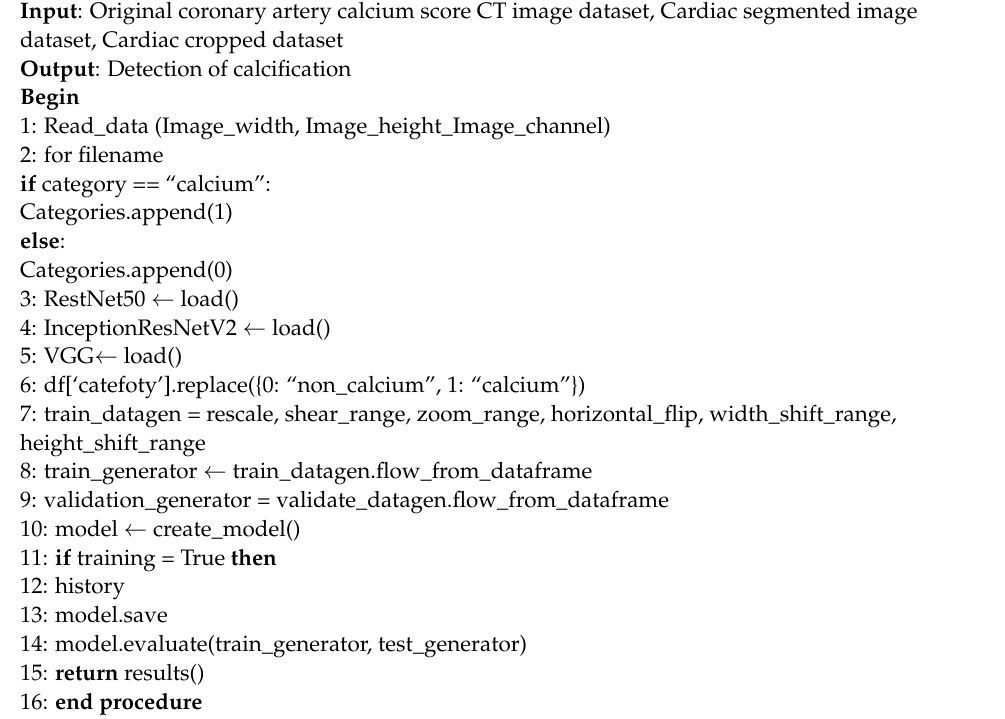
Algorithm 1: Pseudocode for training coronary artery calcium score CT images-Train model